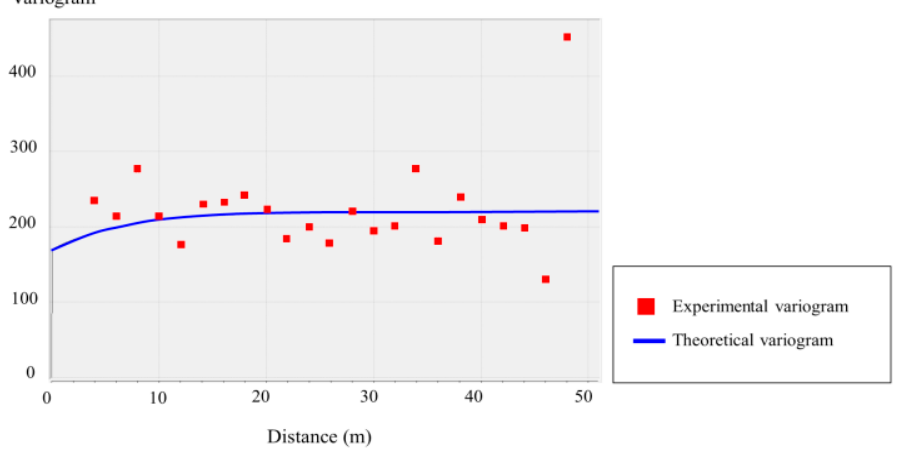
Figure 4. Variogram modeling of the Pb content of the target area. 181